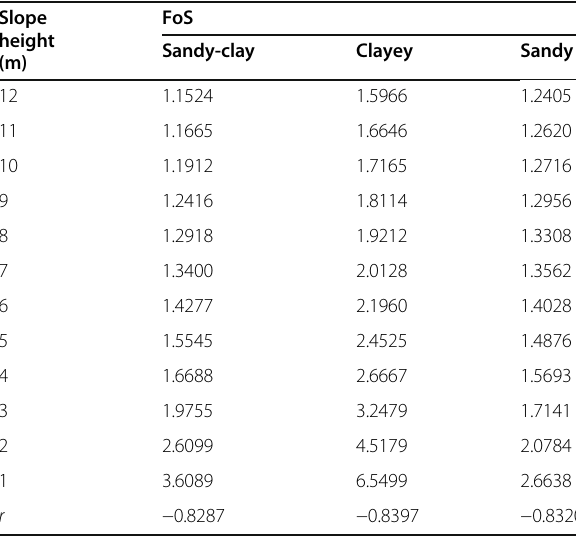
Table 4 Slope height and factor of safety